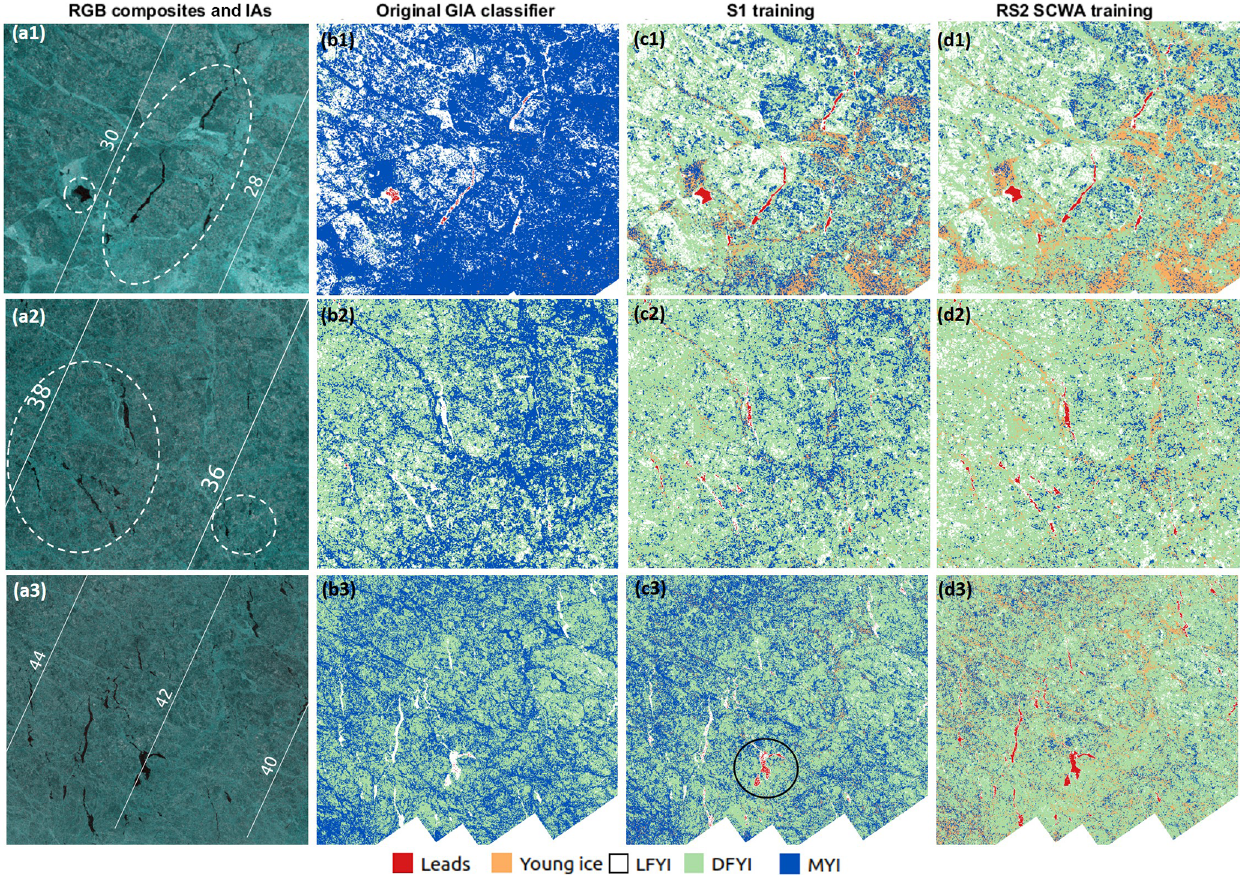
Figure 9. Comparison of classification results in different IA ranges for the RS2 SCWA scene on 5 March 2015, where IA contours with values are shown in white, and main areas containing the leads class are circled in white in (a1–a3)